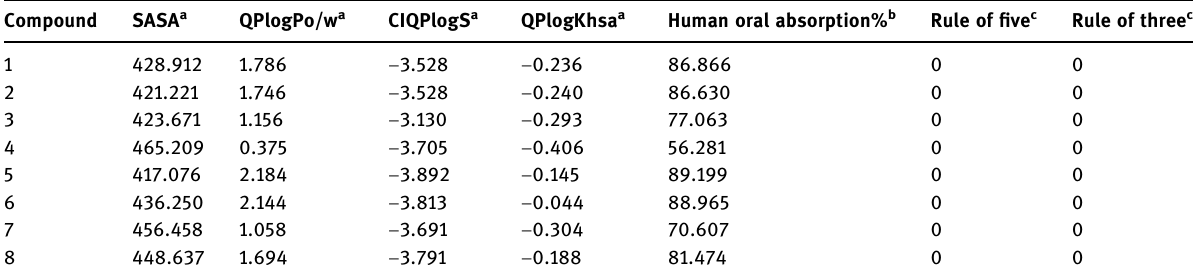
Table 3: Predicted ADME pro fi les of compounds 1 –